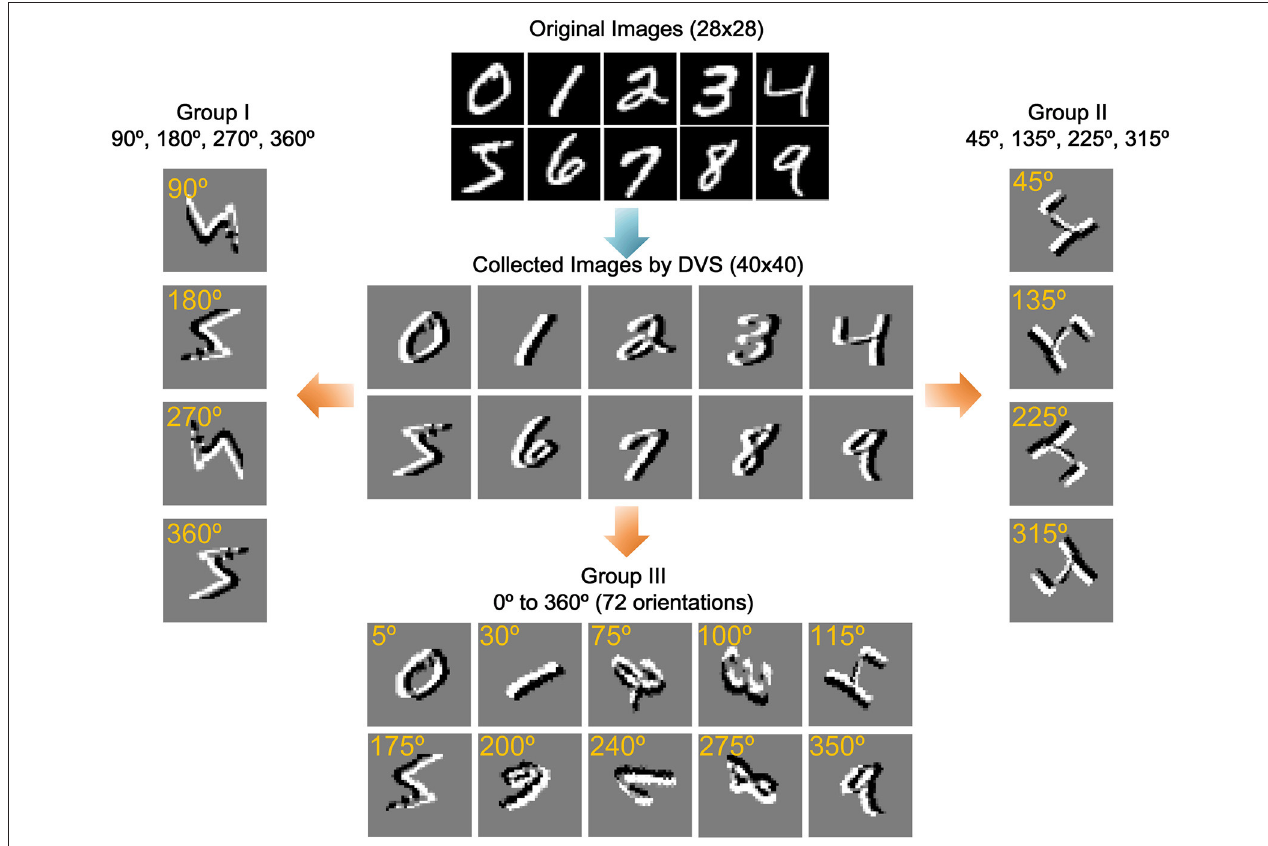
FIGURE 6 | Training samples and three groups of rotated samples. The original images adopt a standard handwritten digit dataset from the Mixed National Institute of Standards and Technology (MNIST). The collected images simulate the moving state of objects by a differencing method. The remaining three groups of images are obtained by rotating the collected images in specific